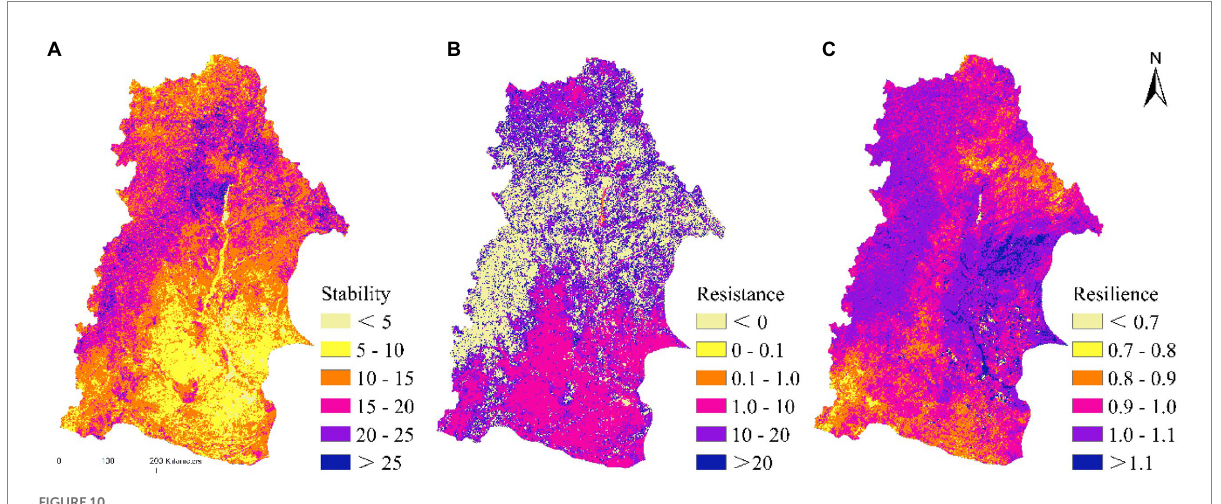
FIGURE 10 The spatial distribution of stability, resistance, and resilience of NDVI to